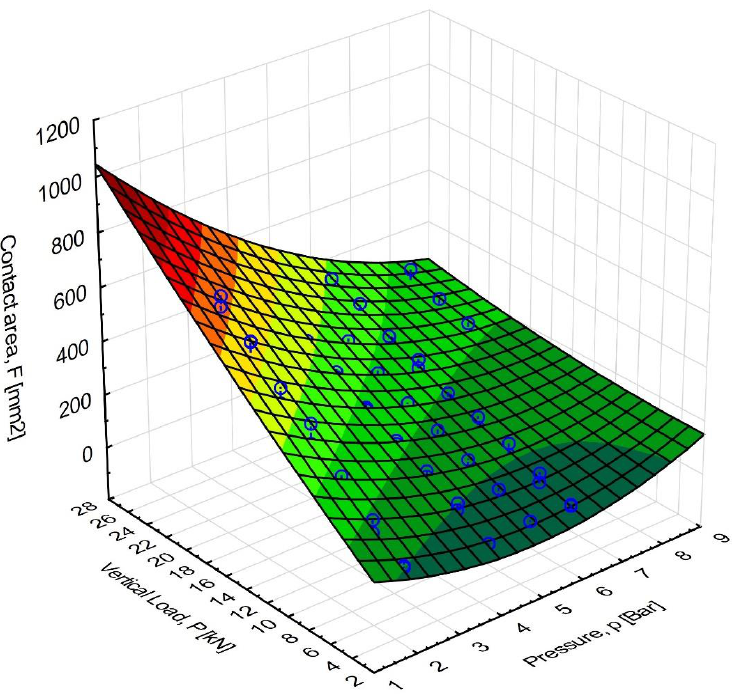
Figure 21. Contact surface area for aircraft tires.